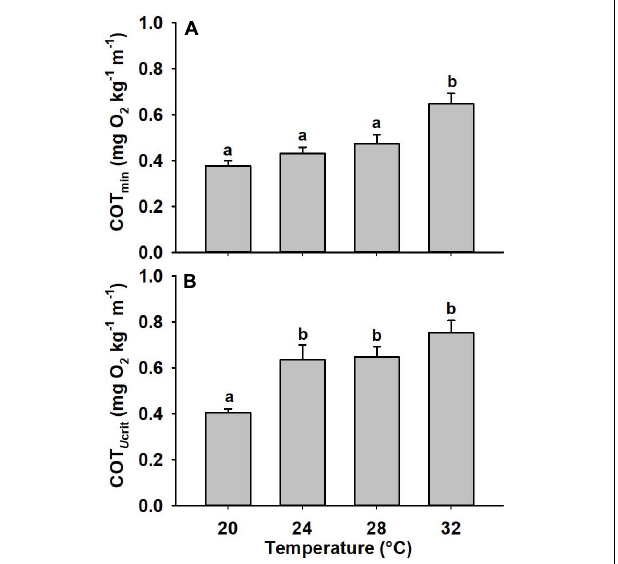
FIGURE 3 | Cost of transport of mahi acclimated to different temperatures. Minimum cost of transport (COT min ) (A) and cost of transport at U crit (COT U crit ) (B) in mahi exposed to 20, 24, 28, or 32 ◦ C ( n = 12, 12, 12, 9, respectively). Data were normalized for body mass by scaling COT min and COT max values predicted for a 40 g fish (COT min = 0.79, COT U crit = 0.59) (Stieglitz et al., 2016). Different lowercase letters denote statistical significance ( p < 0.05) between temperatures performed using post hoc pair-wise comparisons. Values represent means ±